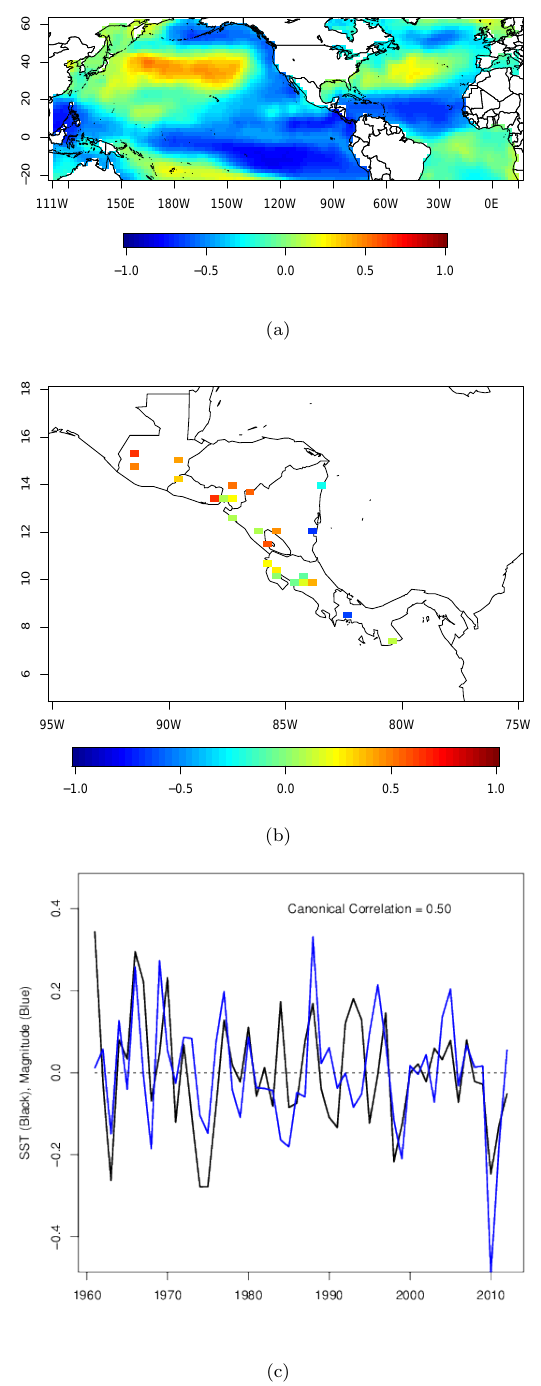
Figure 11. CCA mode 3 for MSD magnitude. X (a) and Y (b) load- ings, and (c) the time scores.